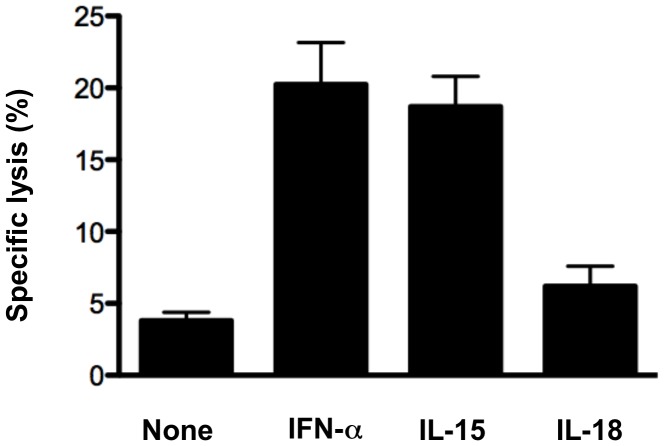
Highly purified NK cells exhibit enhanced cytotoxicity toward target cells in response to treatment with IFN-α.Sorted NK cells (>99% pure) were cultured in vitro for 6 hours with or without indicated cytokines, then combined with 51Cr-labeled YAC-1 targets (E:T = 10∶1) to assess cytotoxic activity. Bars represent the average specific lysis of target cells for each condition. Error bars denote the SEM. Data are representative of two independent experiments.